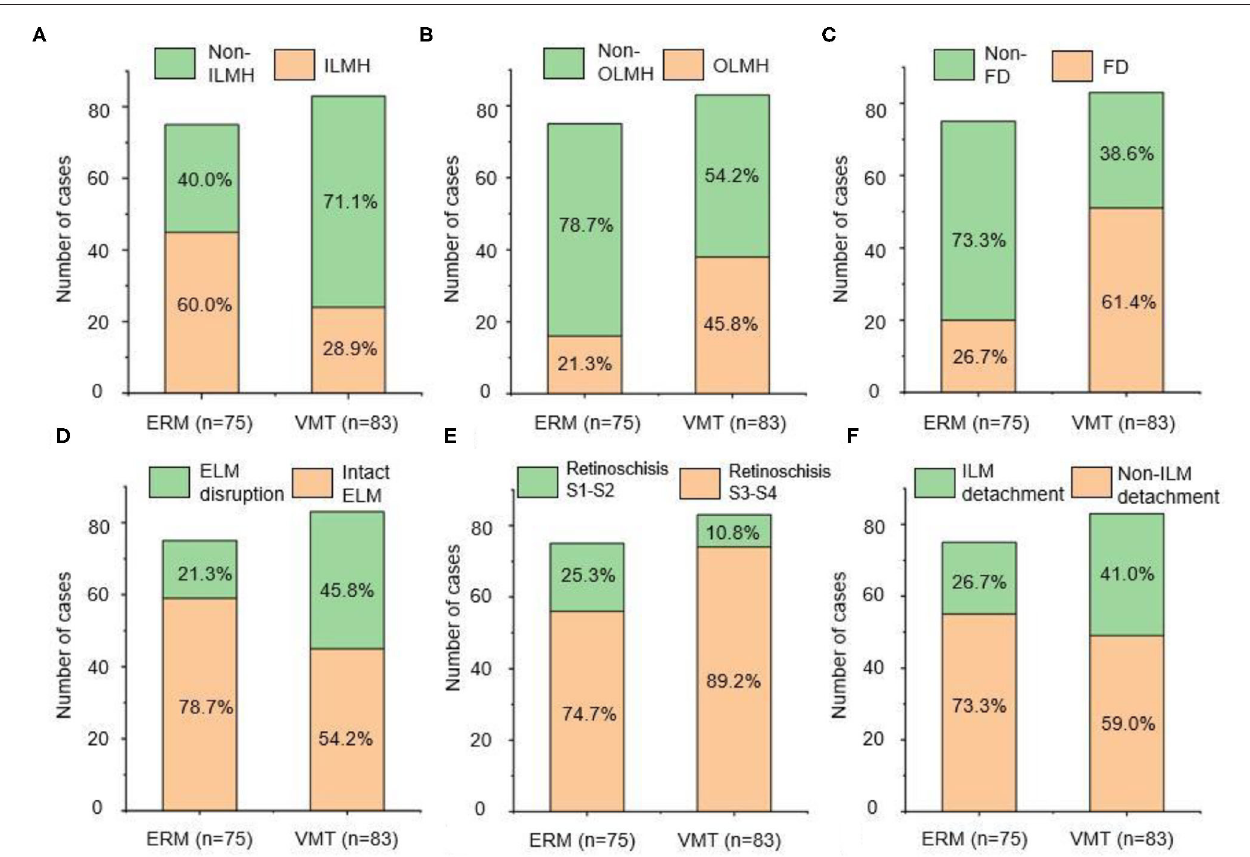
FIGURE 2 | The prevalence of different anatomical configuration: (A) ILMH, (B) OLMH, (C) FD, (D) ELM integrity, (E) degree of retinoschisis, (F) ILM detachment. The left side of each figure presented the ERM group, and the right side of each figure presented the VMT group. ERM, epiretinal membrane; VMT, vitreomacular traction; ILMH, inner lamellar macular hole; OLMH, outer lamellar macular hole; FD, foveal detachment; ELM, external limiting membrane; ILM, inner limiting membrane.